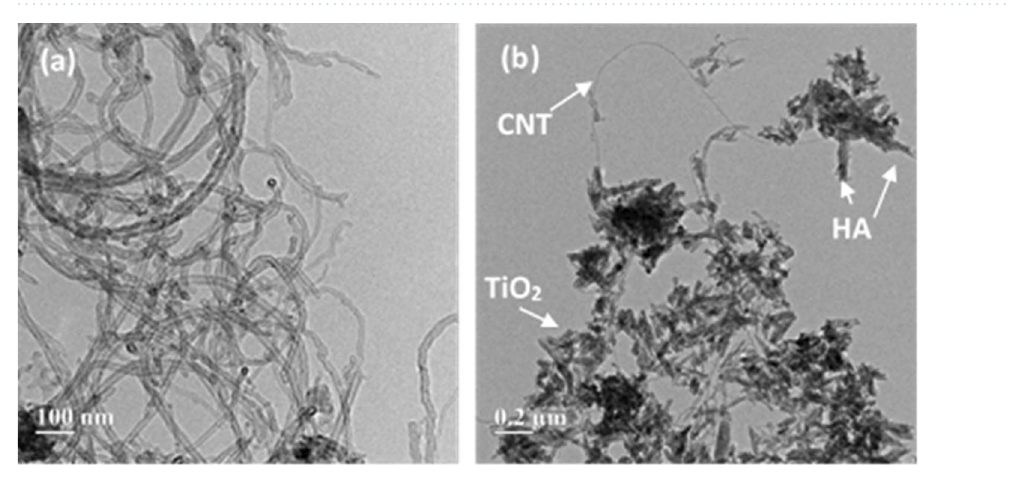
Figure 4. TEM images of ( a ) CNTs and ( b ) S3.0